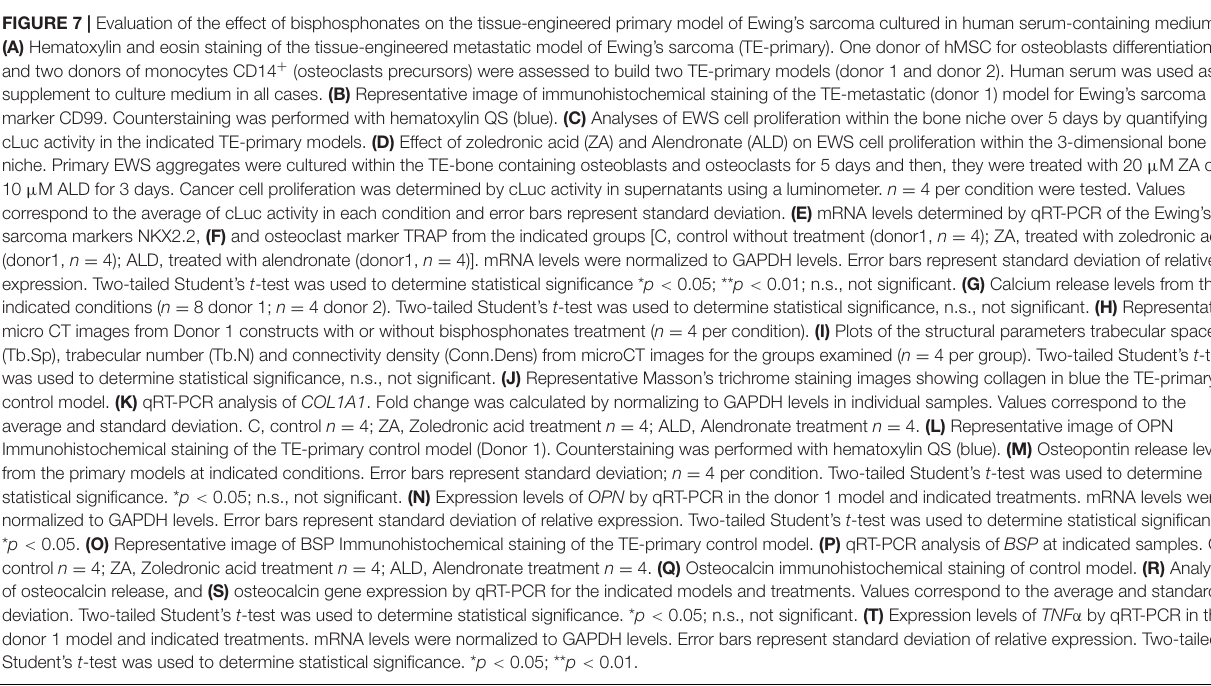
Frontiers in Bioengineering and Biotechnology |